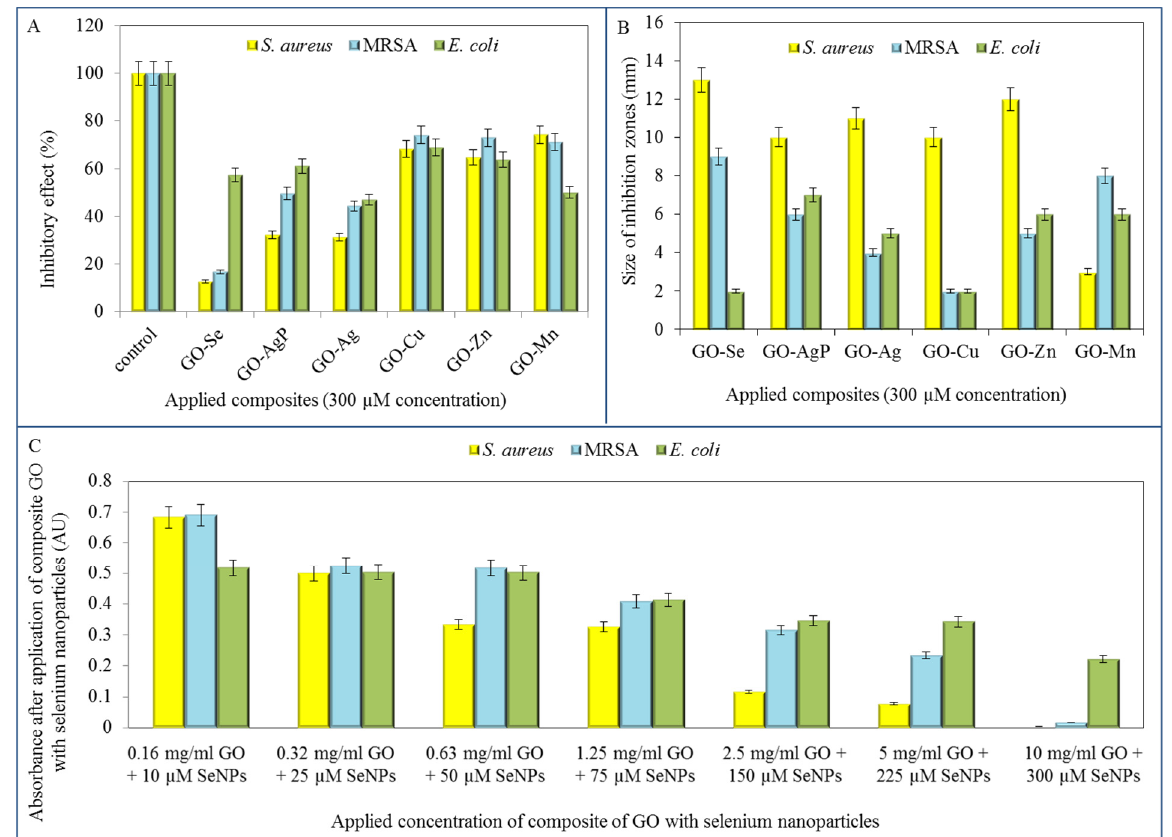
Figure 4. Determination of bacterial growth after the application of GO composites with metal- or metalloid-based nanoparticles. ( A ) Percentage of bacterial growth after application of 300 µM concentration of tested composite using method of growth curves after 24 h of measurement; ( B ) Determination of inhibition zones arising after application of 300 µM concentration of tested composites on S. aureus , MRSA and E. coli ; ( C ) Determination of bacterial growth after the application of various concentrations of composite of GO with selenium